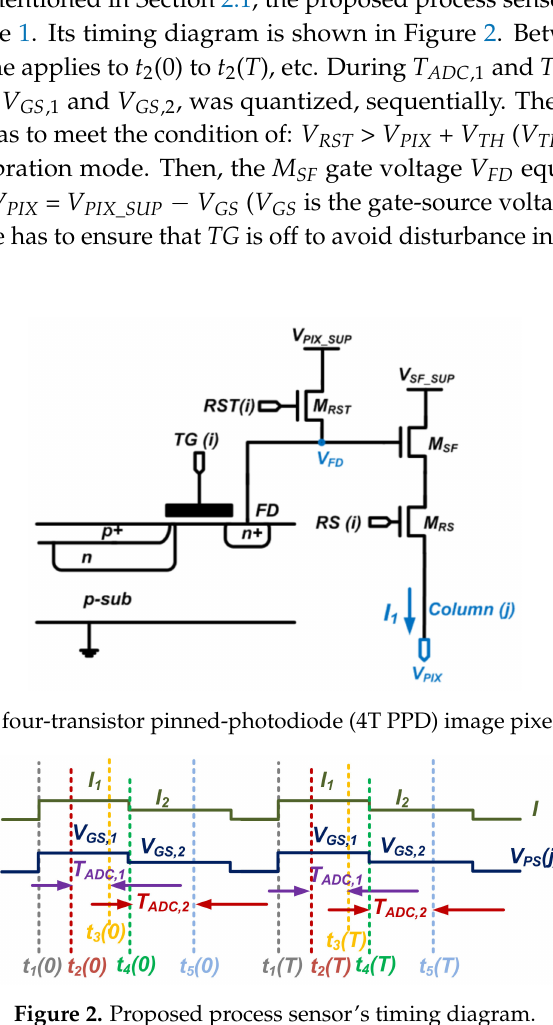
Figure 2. Proposed process sensor’s timing